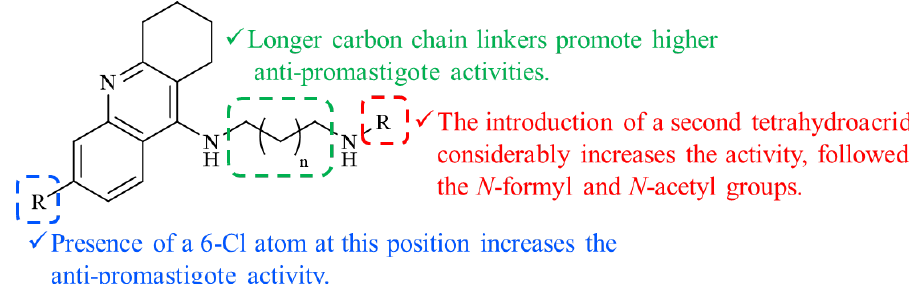
Figure 5. Structure–antileishmanial activity relationship study of 1,2,3,4-tetrahydroacridine Figure 5. Structure – antileishmanial activity relationship study of 1,2,3,4-tetrahydroacridine deriva- tives.